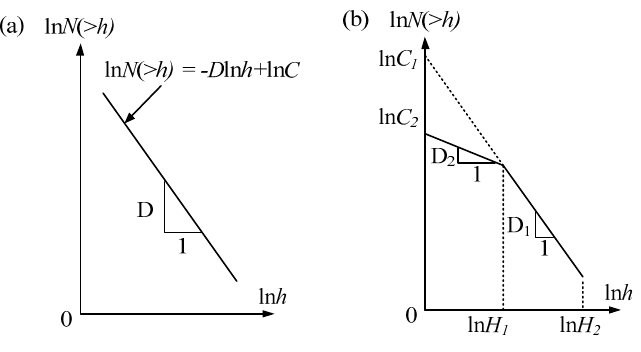
Figure 1. ( a ) simple fractal model; ( b ) bifractal model.